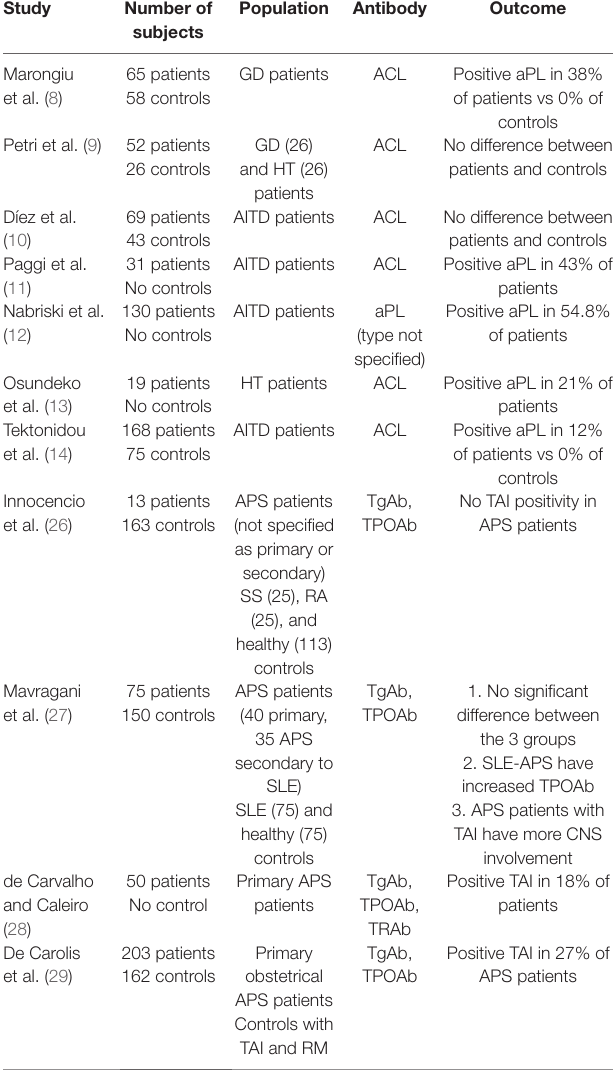
TAble 1 | Association between TAI and